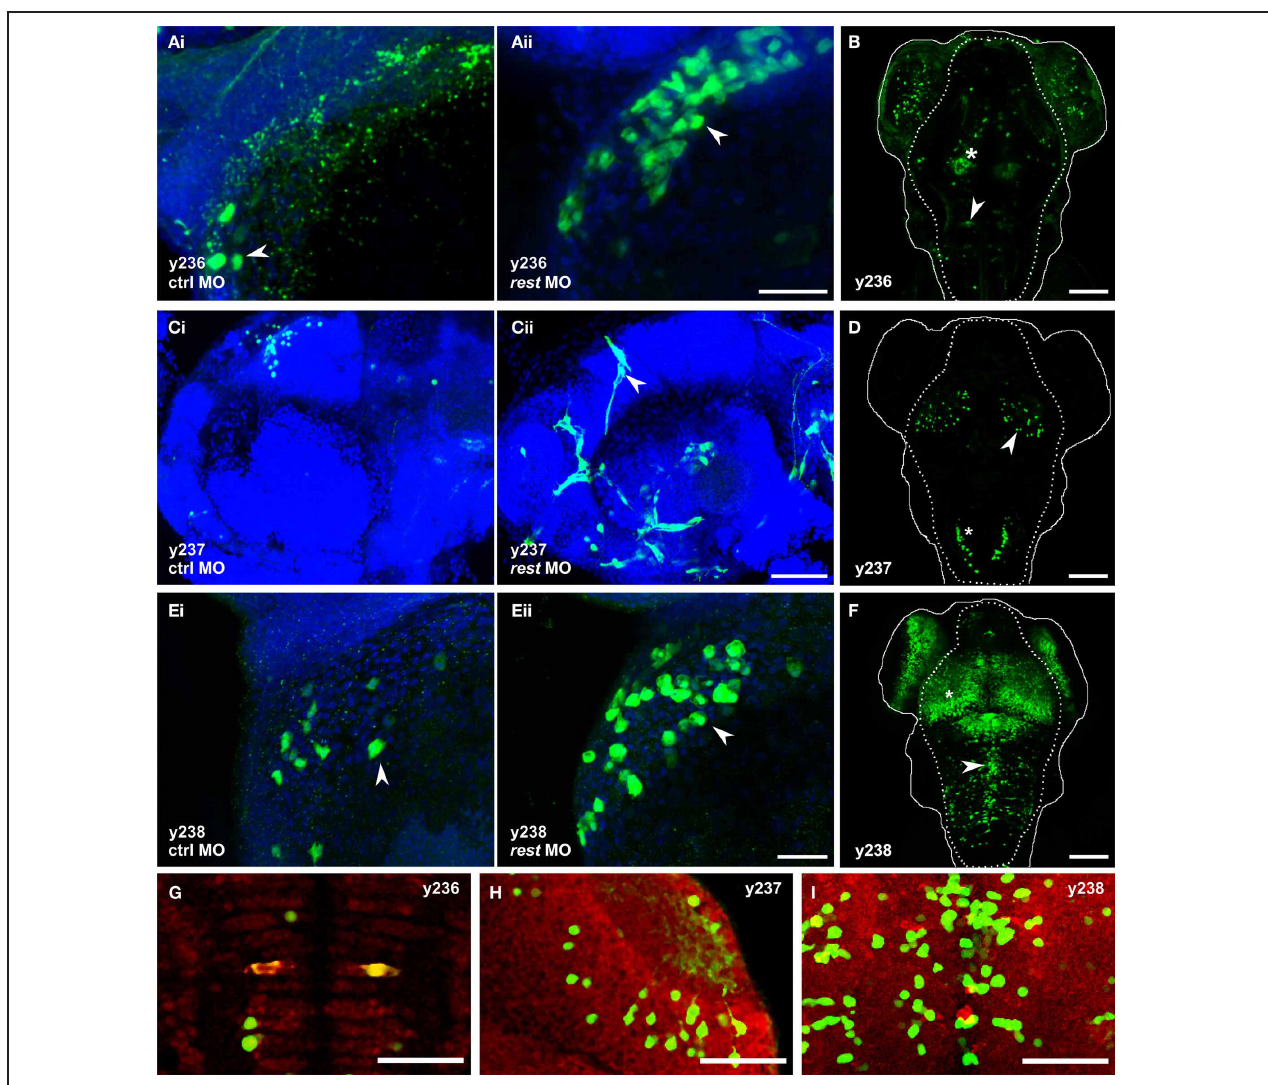
FIGURE 4 | Knockdown of rest reveals non-neuronal expression in REx2 enhancer trap lines. In (A,C,E) confocal stacks show 2dpf embryos immunostained with anti-Kaede (green), counterstained with Hoechst (blue). (B,D,F) are live confocal stacks of Kaede expression in 4dpf embryos with the outline of the head (solid line) and brain (dotted line). (A) Et(REx2-cFos:Gal4ff)y236;Tg(UAS:Kaede)s1999t embryos injected with (i) control morpholino or (ii) morpholino targeting rest . Arrowheads show heart cells. (B) At 4dpf y236 larvae show reporter expression in hypothalamus (asterisk) and the Mauthner cells (arrowhead). (C) Et(REx2-cFos:Gal4ff)y237;Tg(UAS:Kaede)s1999t embryos injected with (i) control morpholino or (ii) morpholino targeting rest . Arrowheads show